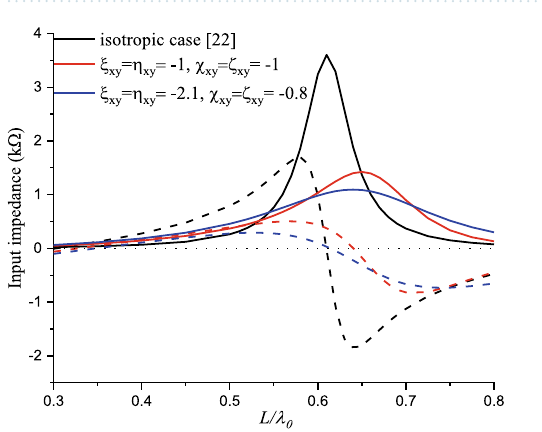
Figure 24. Distribution of the electromagnetic field components for ( χ xy and ( d – f ) magnetic field components.